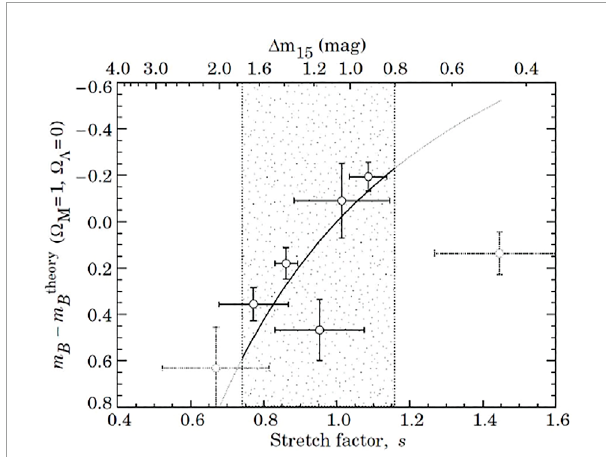
FIGURE 1 m B magnitudes versus the best-fit stretch factor, s , for high-redshift supernovae. The upper axis gives the equivalent values of Δ m 15 = 1 . 96 ( s −1 − 1 )+ 1 . 07. Figure from Perlmutter et al. (Supernova Cosmology Project) in Thermonuclear Supernovae (ed. P. Ruiz–Lapuente et al., 1997). © Kluwer Academic Publishers. Reproduced with